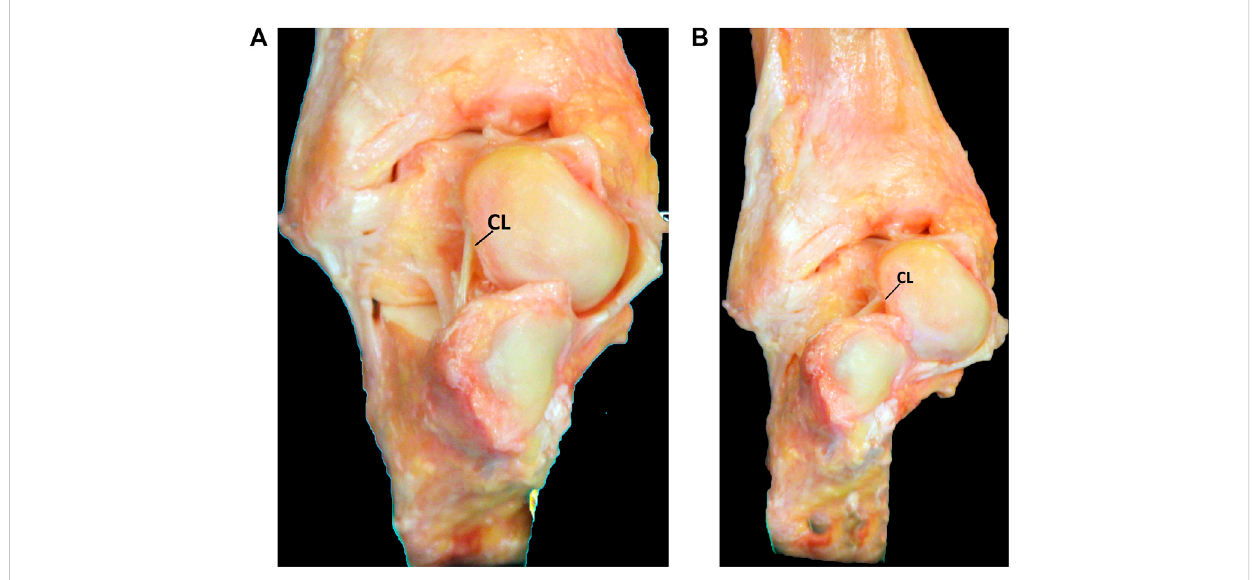
FIGURE 4 Anterior view of the hindfoot. The CL allows a swinging motion of the calcaneus around the talar neck. (A) . In inversion, the CL is taut in a vertical position. (B) . In eversion the CL is taut in a more horizontal